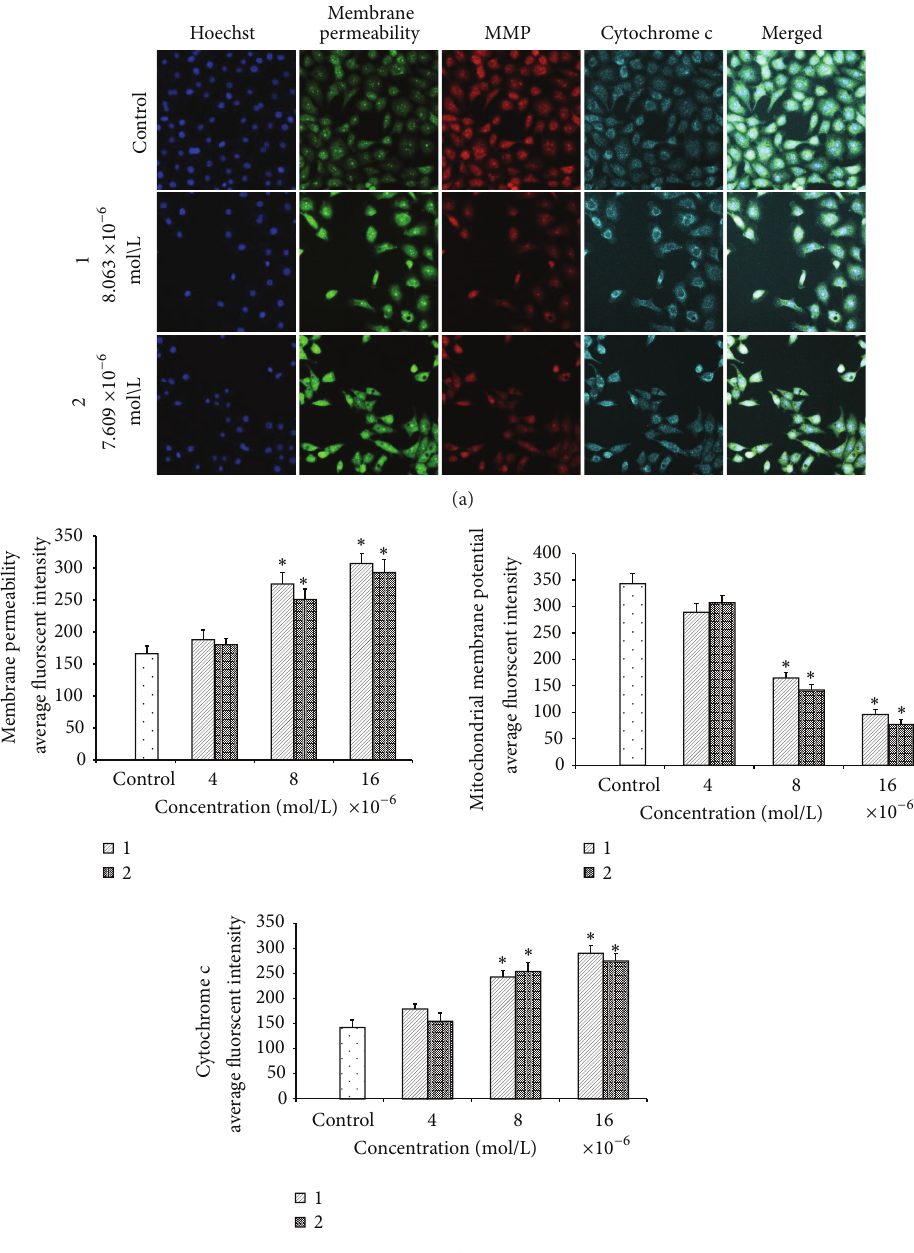
Figure 14: Effects of the Quinazoline Schiff bases on nuclear morphology, membrane permeability, mitochondrial membrane potential (MMP), and cytochrome c release. (a) Representative images of MCF-7 cells treated with medium alone and at 4 × 10 −6 , 8 × 10 −6 , and 16 × 10 −6 mol/L concentrations of compounds and stained with Hoechst 33342 for nuclear, cytochrome c, membrane permeability, and MMP dyes. Both compound induced a noteworthy elevation in membrane permeability and cytochrome c release and a marked reduction in mitochondrial membrane potential (magnification: 200x). (b) Representative bar charts indicating dose-dependent increased cell permeability reduced MMP and increased cytochrome c release in treated MCF-7